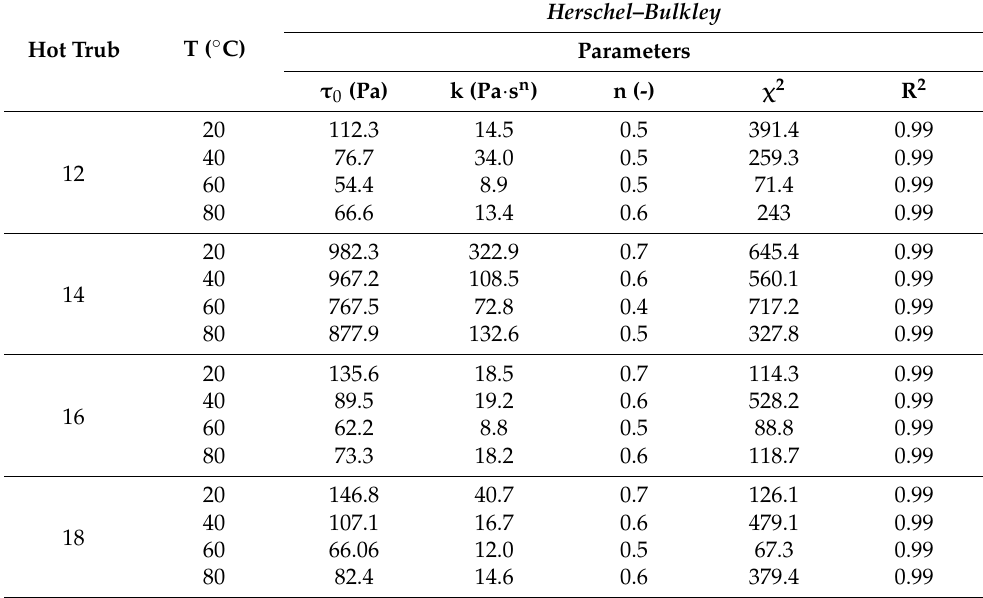
Table 3. Herschel–Bulkley model parameters for the tested hot Table 3. Herschel – Bulkley model parameters for the tested hot trubs.